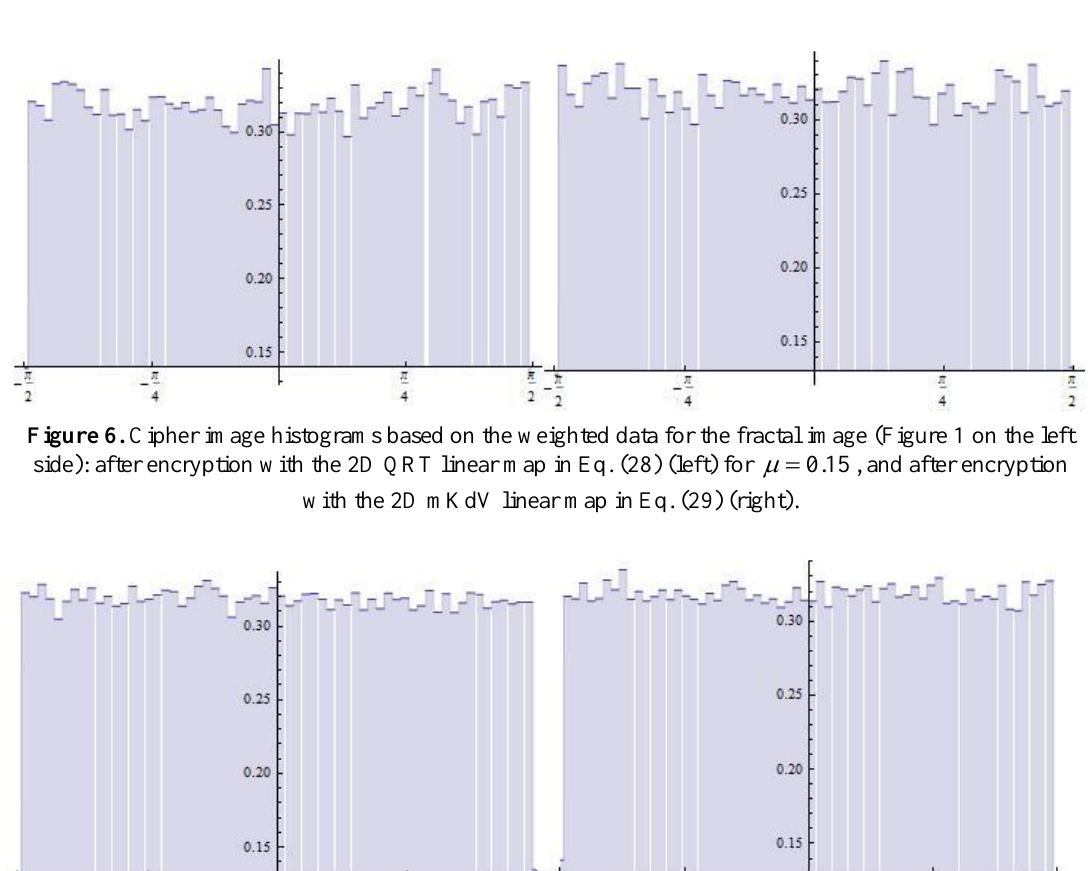
413 | Vol. 7, No. 3, 2022